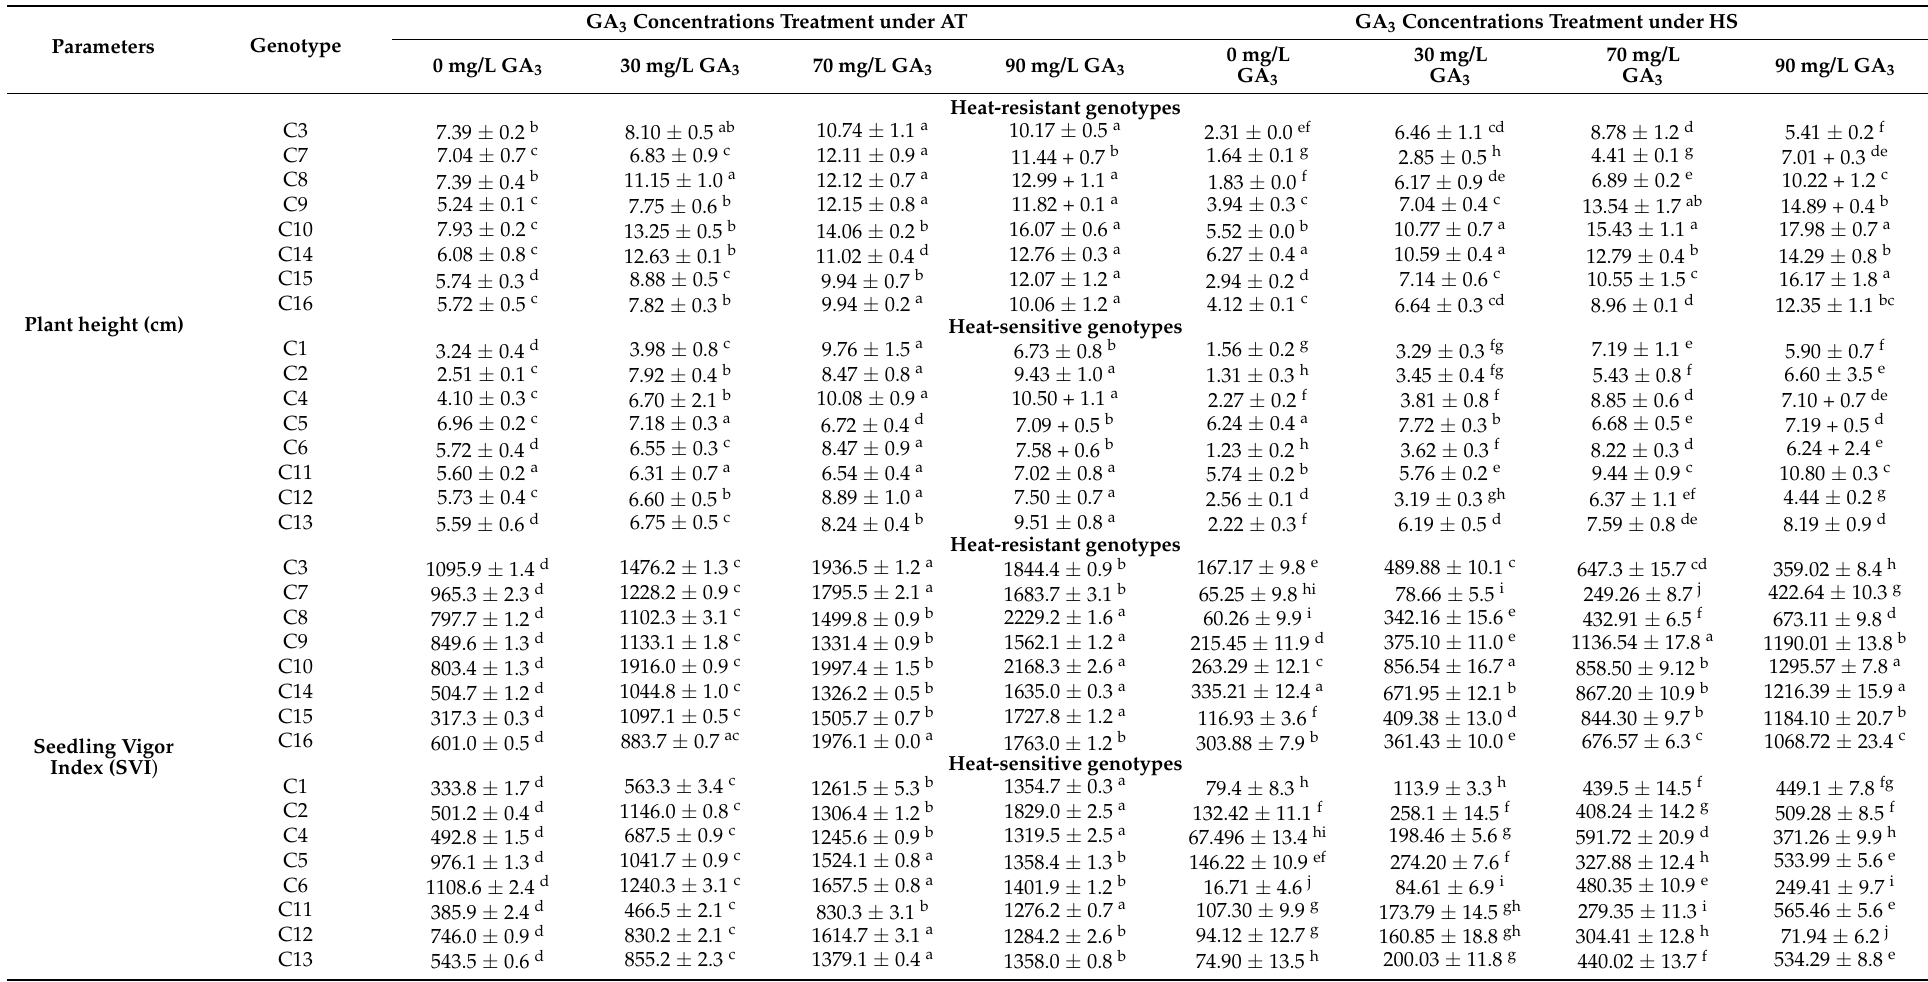
Table 2. Effects of GA 3 concentrations (mg/L) on plant development of the selected heat-resistant and heat-sensitive Cyclamen genotypes under ambient temperatures and heat